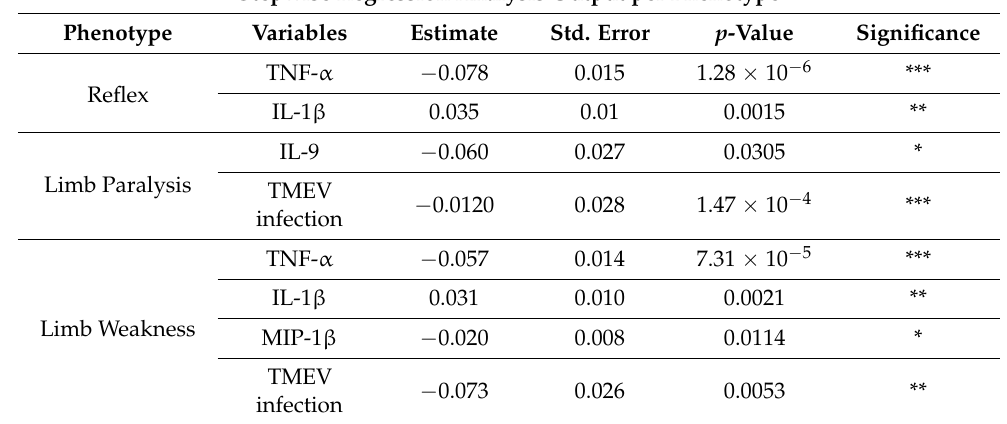
Table 5. Analyses identified cytokines and chemokines of interest as potential biomarkers for certain TMEV-induced phenotypes of acute